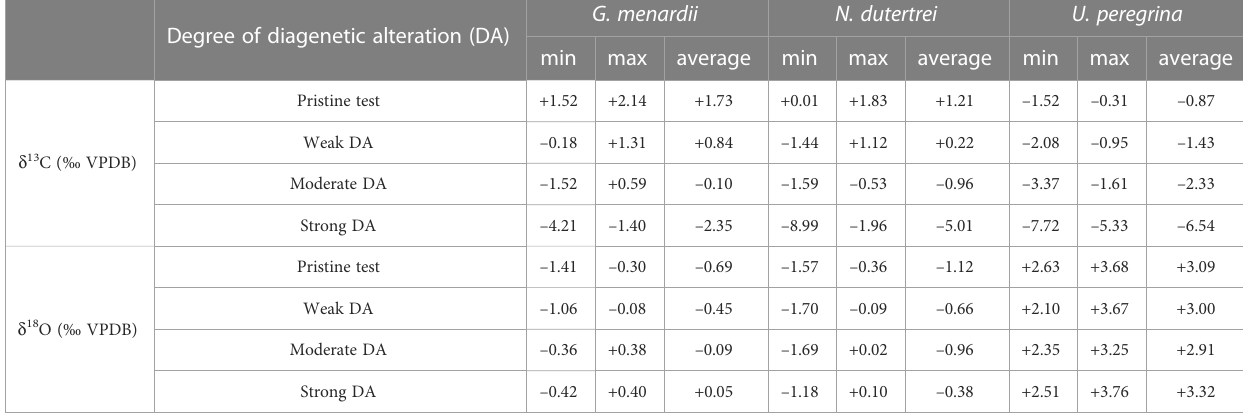
TABLE 2 Overall range and average value of carbon and oxygen stable isotopes for samples with weak, moderate, and strong diagenetic